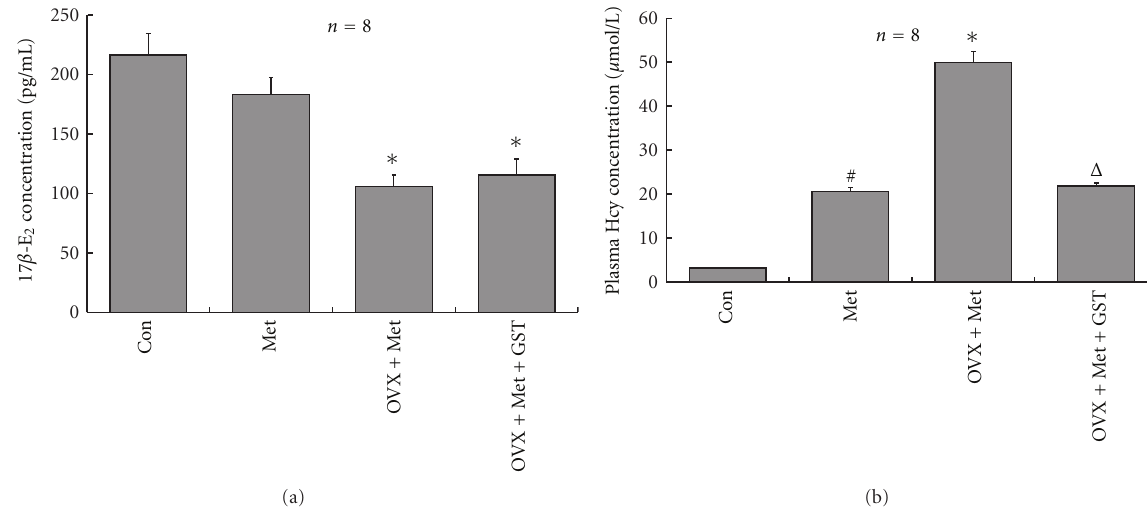
Figure 1: Alterations of plasma 17 β -E 2 and Hcy levels after 12 wk di ff erent treatment. (a) Plasma 17 β -E 2 levels. Ovariectomy induced a significant decrease of plasma 17 β -E 2 ; supplementation with genistein for 12wk had no significant e ff ect on it. (b) Plasma Hcy levels. 2.5% Met diet for 12 wk induced a significant increase in plasma Hcy levels, and ovariectomy could further enhance the increase of Hcy. Genistein supplementation could significantly lower the elevated Hcy levels. The results are shown as mean ± SEM ( n = 8), all P values were obtained by one-way ANOVA analysis. # P < 0 . 05 versus Con; ∗ P < 0 . 05 OVX + Met versus Met; Δ P < 0 . 05 versus OVX + Met